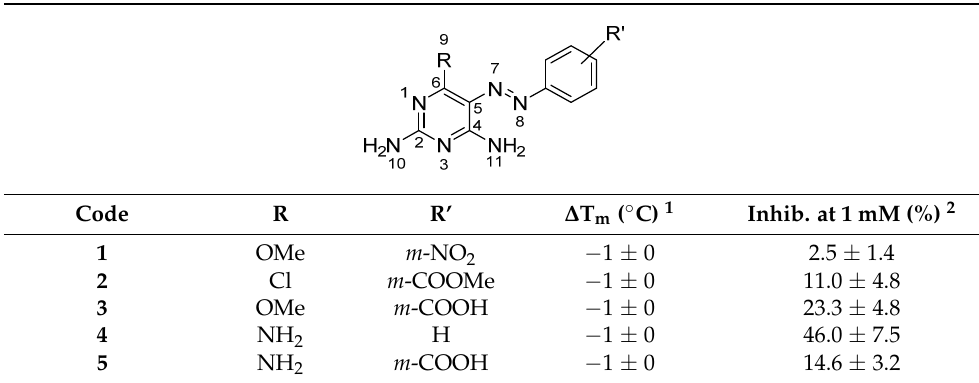
Table 1. Structure and screening data for 5-phenylazo-2,4-diamino pyrimidine hit compounds (series 1).